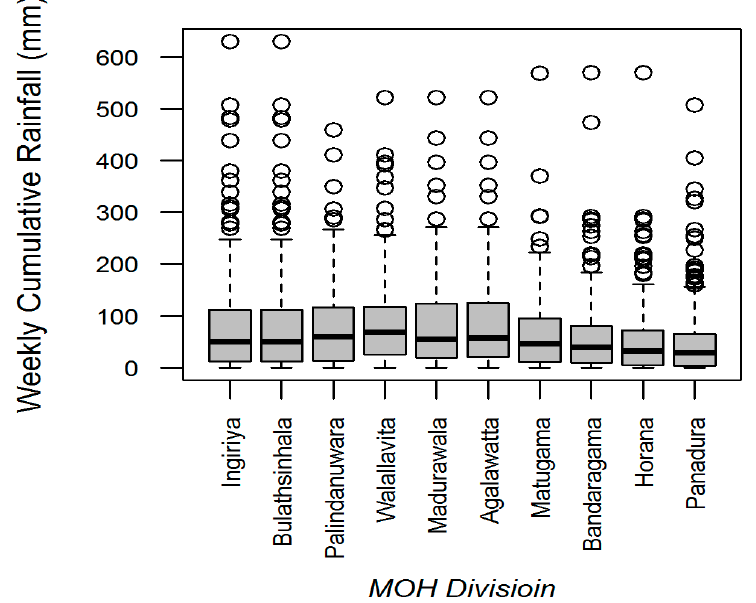
Figure 2. Distribution of weekly cumulative rainfall in all MOH divisions in Kalutara district, Sri Lanka, 2009–2013. The upper and lower borders of the box represents the interquartile range and the horizontal thick bar within the box indicate the median (50th percentile). The vertical lines extending from the boxes (whiskers) indicating variability outside the upper and lower quartiles. The circles above represent the outliers.